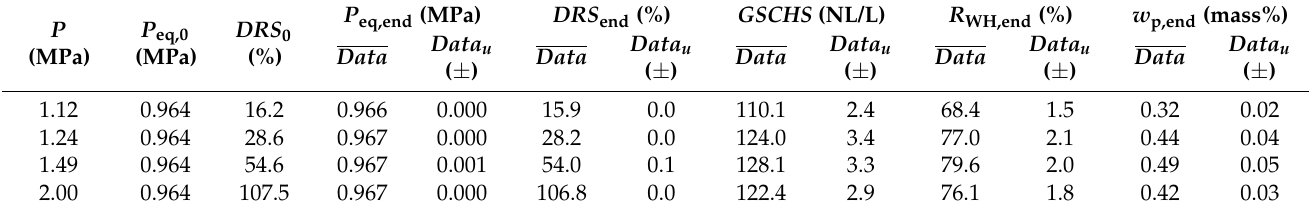
Table 3. The effect of pressure on the final state of ethylene hydrate